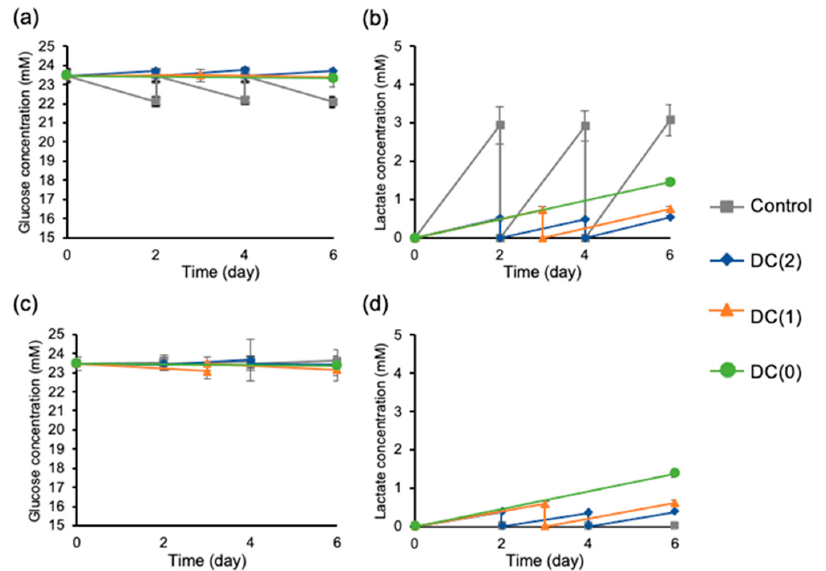
Figure 2. Glucose and lactate concentration of differentiation medium and dialysis medium were measured at every medium change during the differentiation. ( a ) Glucose concentration of differentiation medium, ( b ) lactate concentration of differentiation medium, ( c ) glucose concentration of dialysis medium, and ( d ) lactate concentration of dialysis medium. Control: without dialysis, medium change 2 times, DC(2): with dialysis, medium change 2 times, DC(1): with dialysis, medium change 1 time, DC(0): with dialysis, without medium change. Data represent mean ± SD of n = 5–6 from two independent experiments.